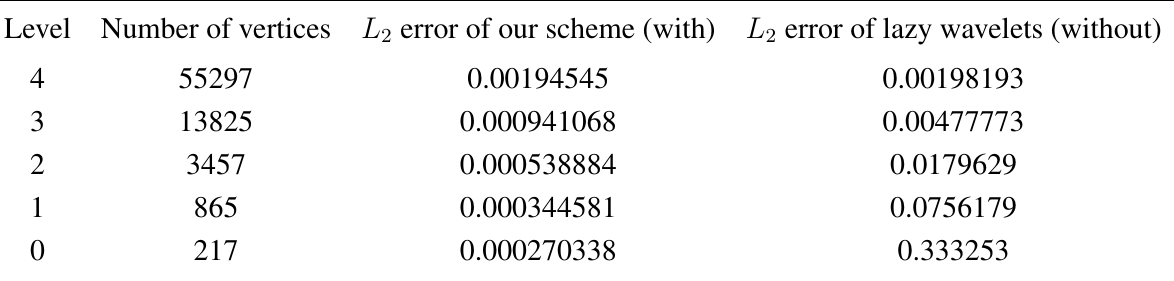
Table 4. L error of mushroom in different levels (with and without 2